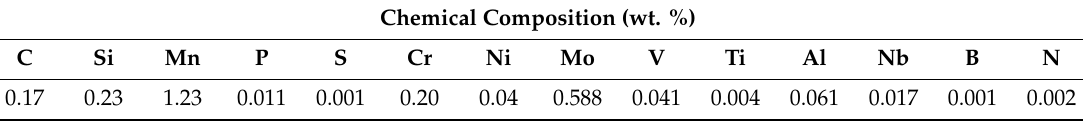
Table 1. Chemical composition and carbon equivalents of the investigated S960QL steel in wt. %. Chemical Composition (wt. %)